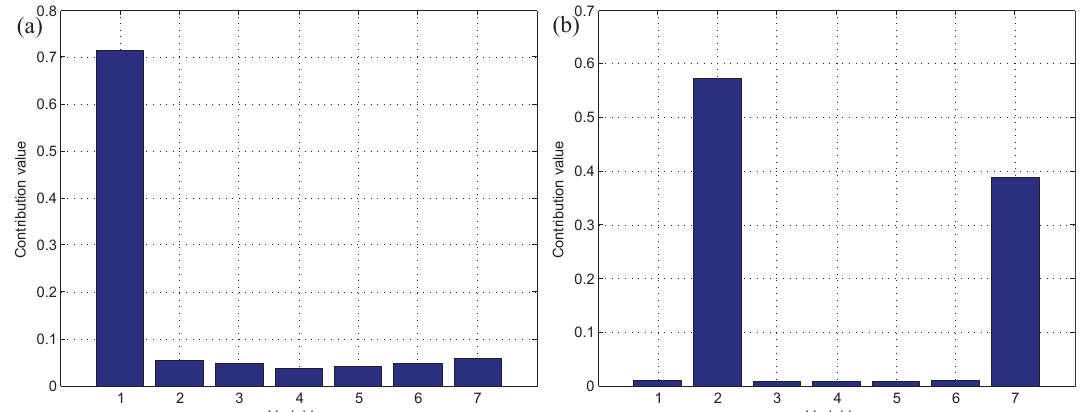
Figure 7. The variable contribution plots of the k-NN method. ( a ) Sample 121; ( b ) sample